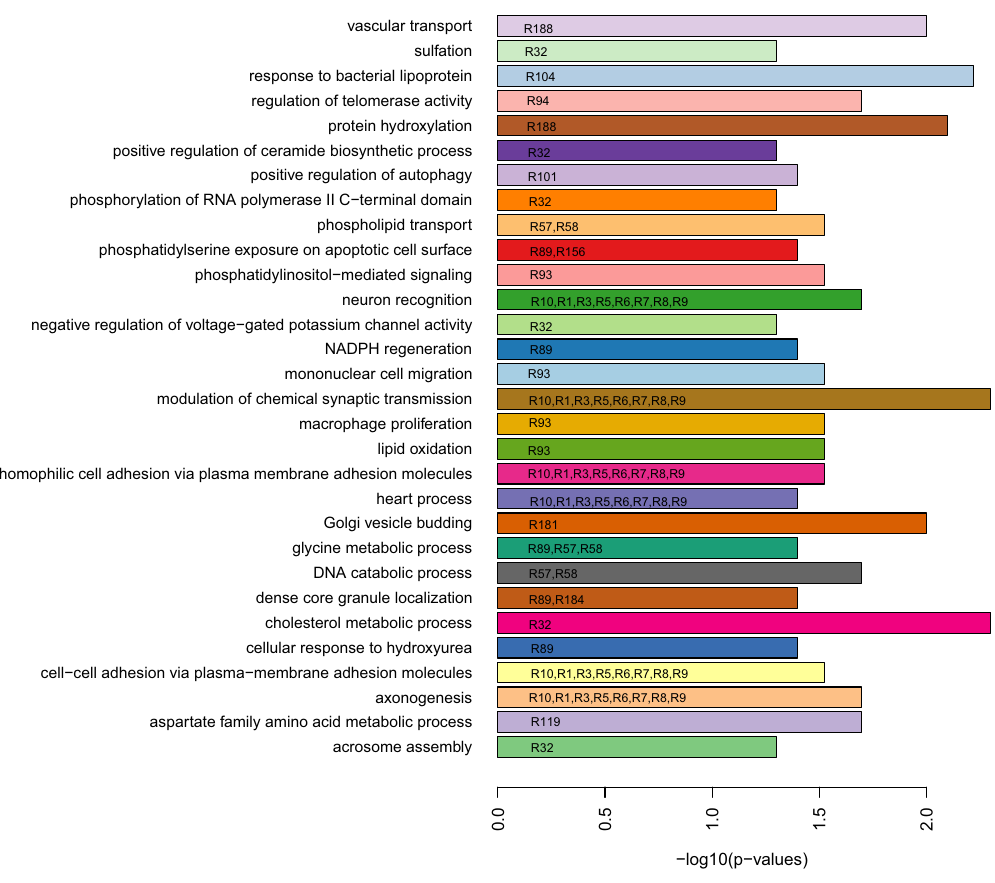
Figure 4. Biological processes (y-axis) from Gene Ontology database that were significantly (FDR < 0.05, x-axis) enriched in SNPs sets from 21 out of the 29 most distinct genotype-lipidome relations. Text within the bars represent the relation (R) identification numbers in which the corresponding biological processes were